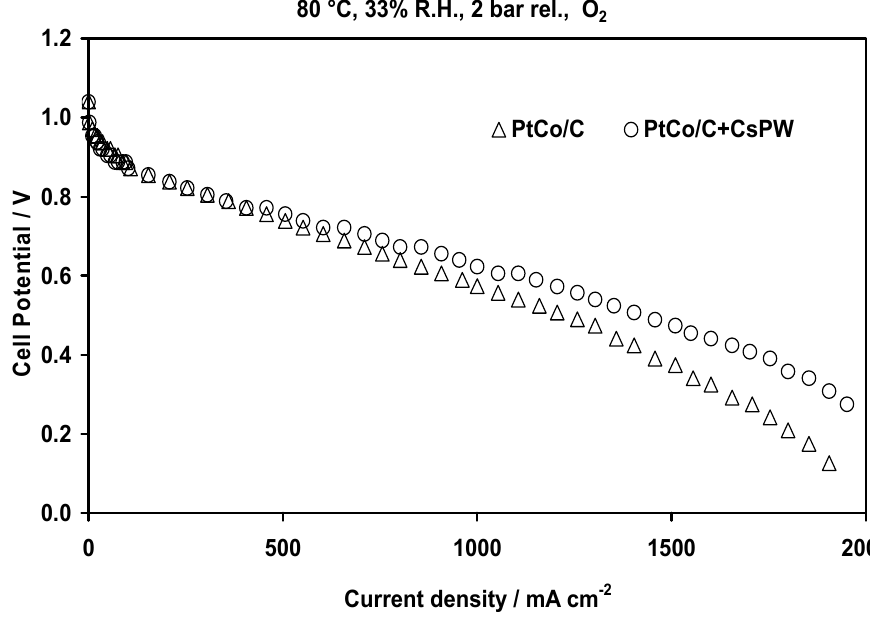
Figure 7. Polarization curves for the promoter-based and the bare MEAs at 80 °C, 2 bar rel., in the presence of low relative humidity (33% R.H.).